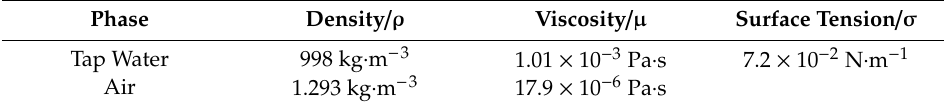
Figure 1. Experimental device diagram of 90-mm bubble column. Table 1. Physical properties of gas–liquid